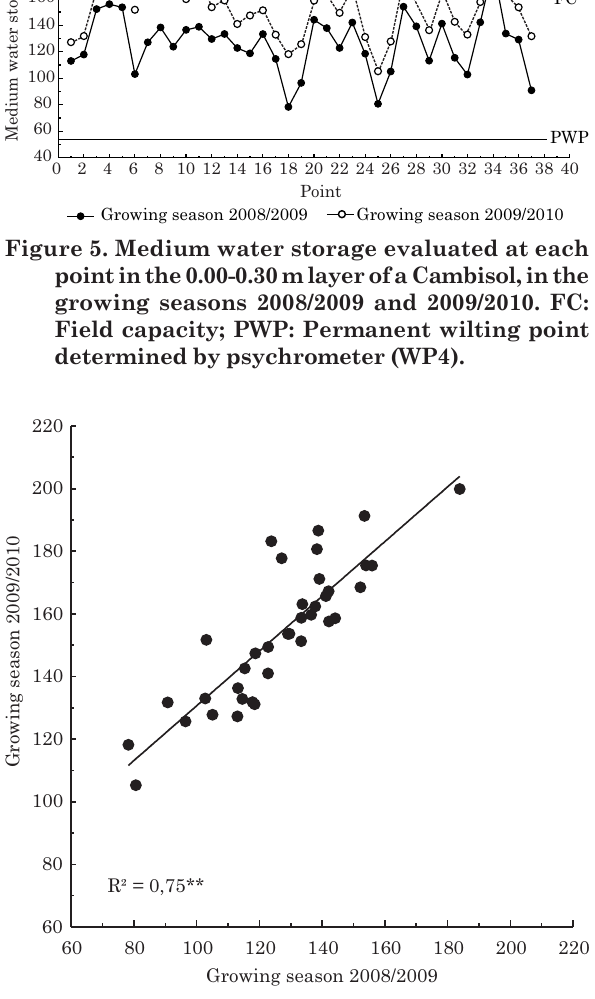
Figure 6. Regression analysis of average water storage (mm), in the layer 0.00-0.30 m, of a Cambisol, for the growing seasons 2008/2009 and 2009/2010.